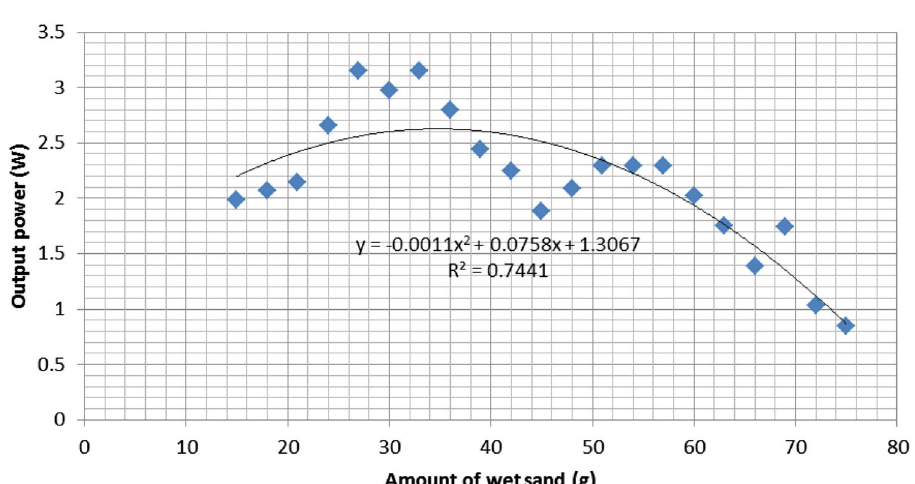
Fig. 10 P out vs. amount of wet